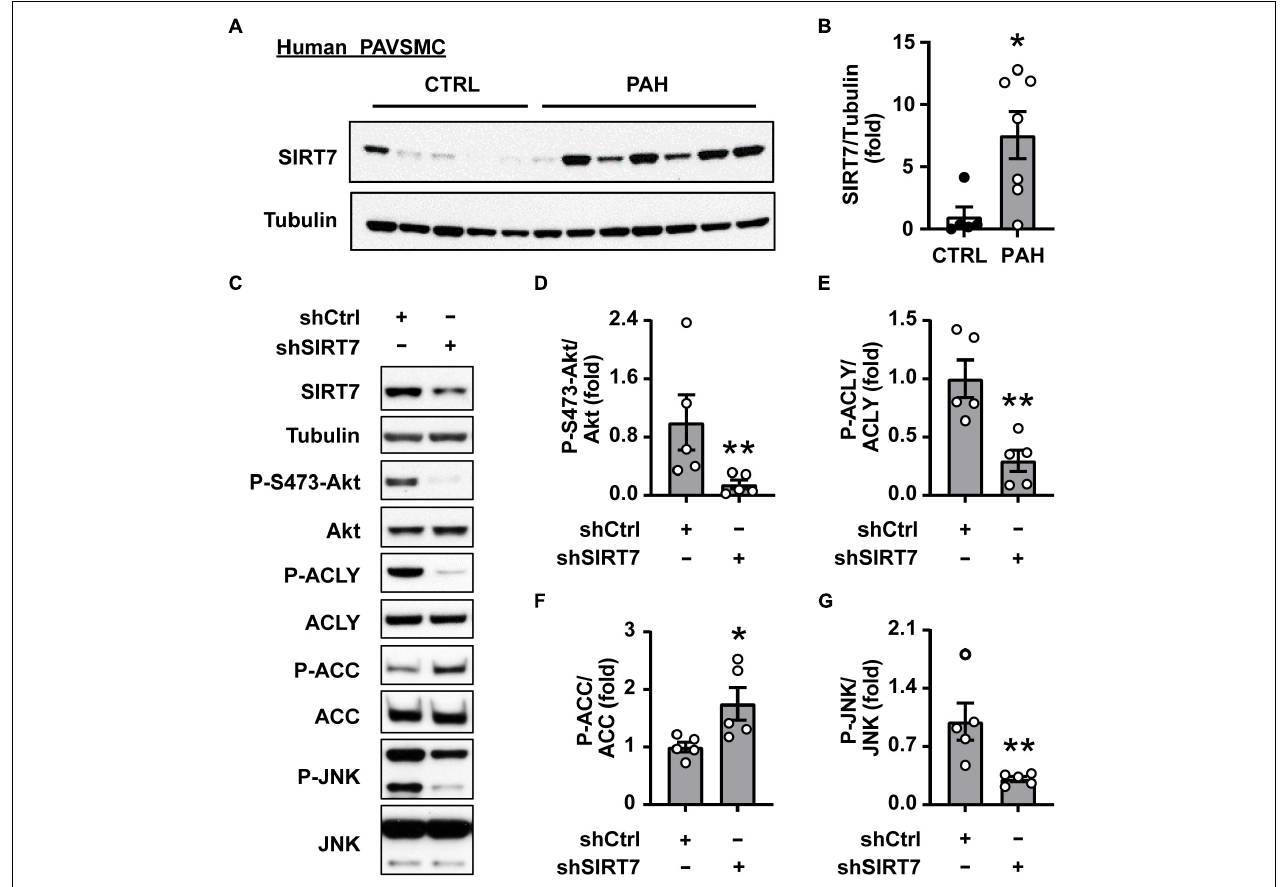
FIGURE 4 | SIRT7 regulates Akt status and lipogenic enzymes activation in human PAH PAVSMC. (A,B) Early passage distal human PAVSMC from five non-diseased (CTRL) and seven PAH subjects were serum deprived for 48 h and subjected to immunoblot analysis to detect indicated proteins. Immunoblots (A) and statistical analysis (B) are shown. Data are means ± SE, fold to control. (C–G) Human PAH PAVSMC were transfected with shRNA SIRT7 (shSIRT7), or control scramble shRNA (shCtrl) for 72 h followed by immunoblot analysis. Data represent fold to shCtrl. Data are means ± SE, n = 5 subjects/group. * p < 0.05, ** p < 0.01 by Mann–Whitney U